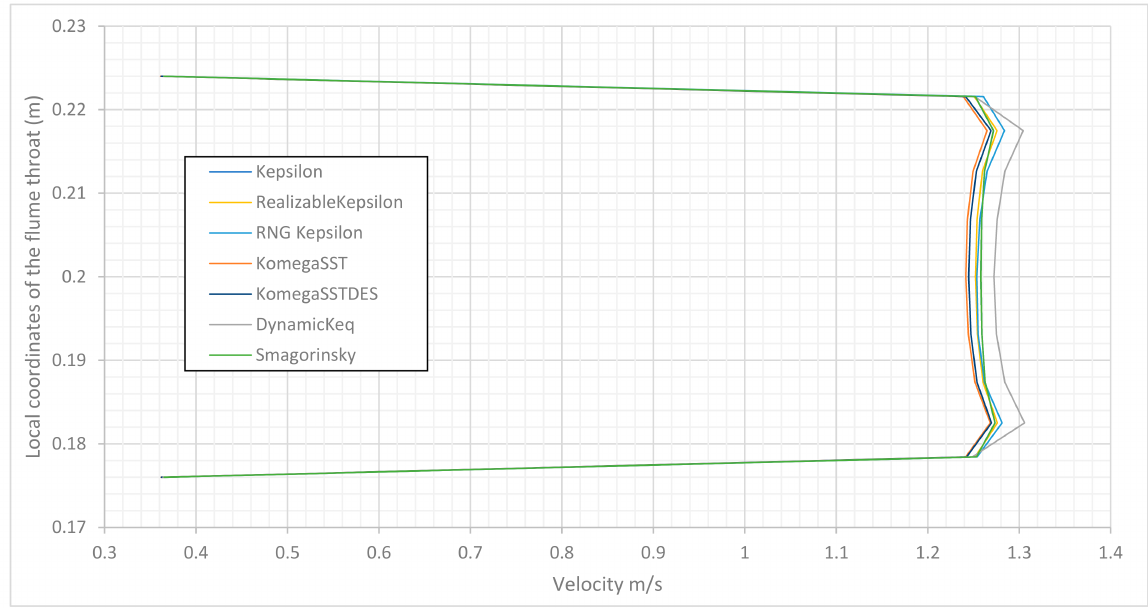
Figure 9. Comparison of the velocity profile at cross-section 5 and the results obtained using the investigated turbu- lence